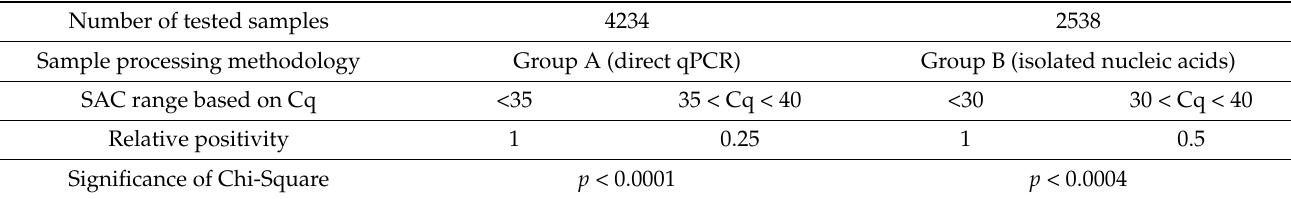
Table 1. Relative frequency of positive results is affected by the Cq values of sample adequacy controls. Number of tested samples 4234 2538 Sample processing methodology Group A (direct qPCR) Group B (isolated nucleic acids) SAC range based on Cq <35 Relative positivity Significance of